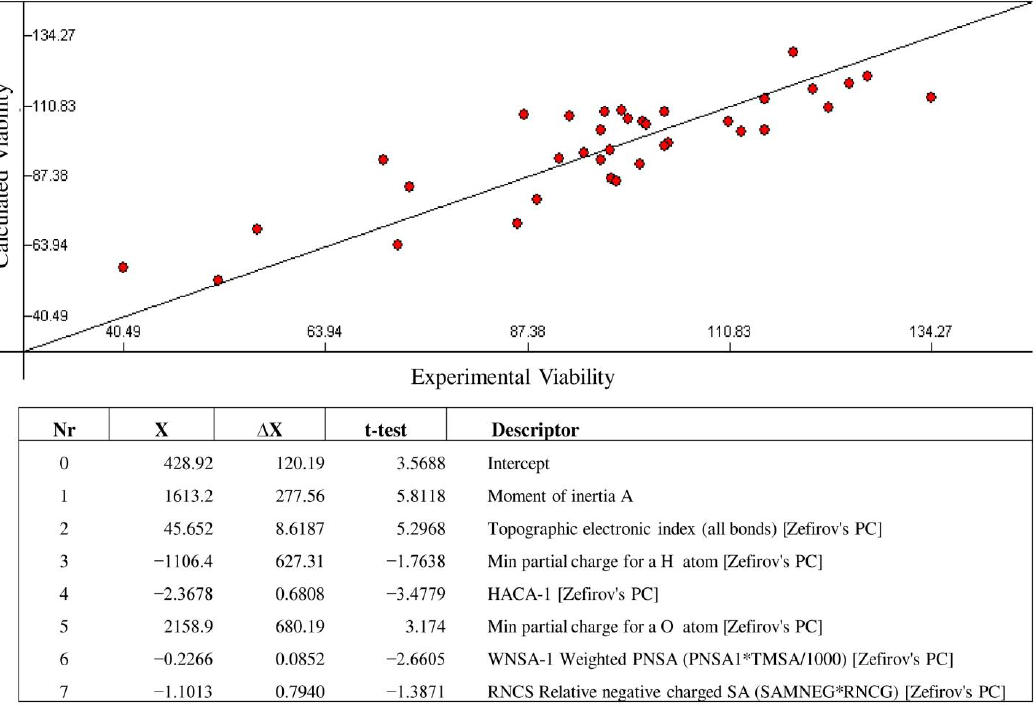
Figure 5. QSAR model obtained with the heuristic method for 36 molecules with the CODESSA software (R 2 = 0.7346, F = 11.07, S = 11.96) . X, ΔX , and t-test are the regression coefficients of the software (R 2 = 0.7346, F = 11.07, S = 11.96). X, ∆ X, and t -test are the regression coefficients of the